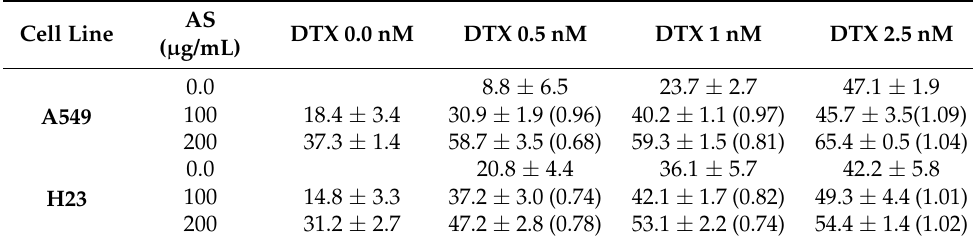
Table 1. Combination index (CI) of concurrent treatment of AS and DTX after 48, whereas CI < 1 indicated synergistic effect; CI = 1 additivity, while CI > 1 indicated